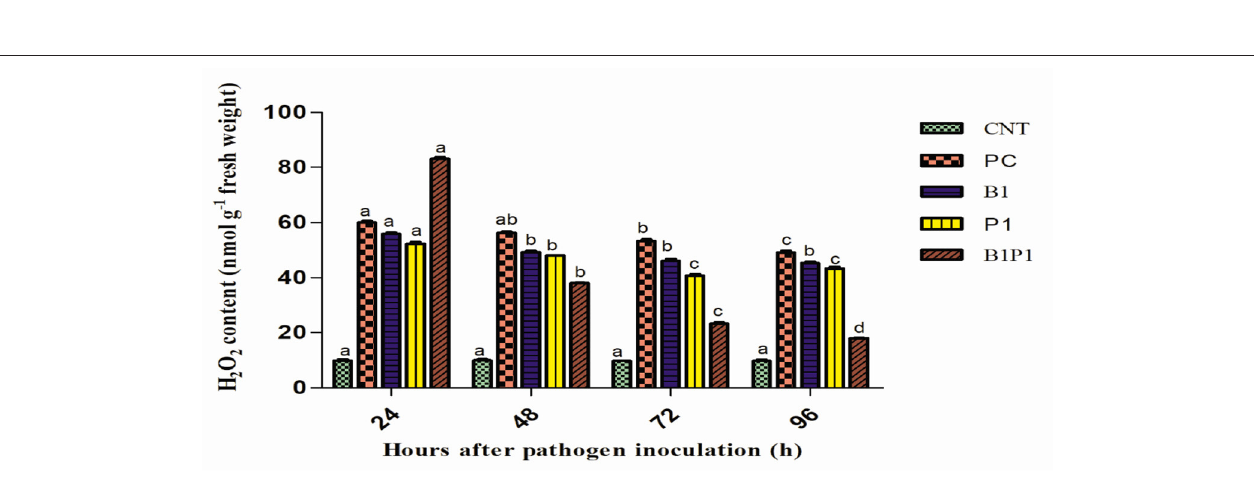
Frontiers in Fungal Biology | www.frontiersin.org